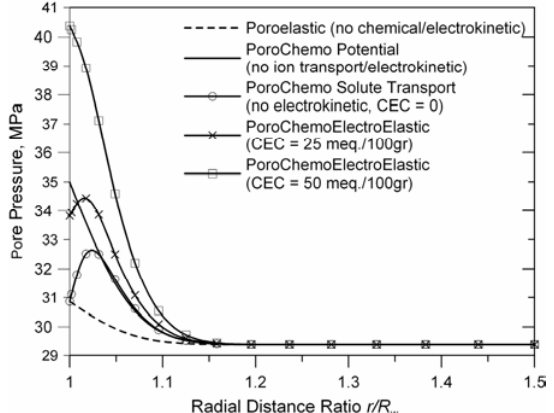
Fig. 12 – Pore pressure distribution in the formation after t = 15 minutes at different CEC values for high mud activity (low mud f . 93 > a f . 90. salinity): a o = 0 mud = 0